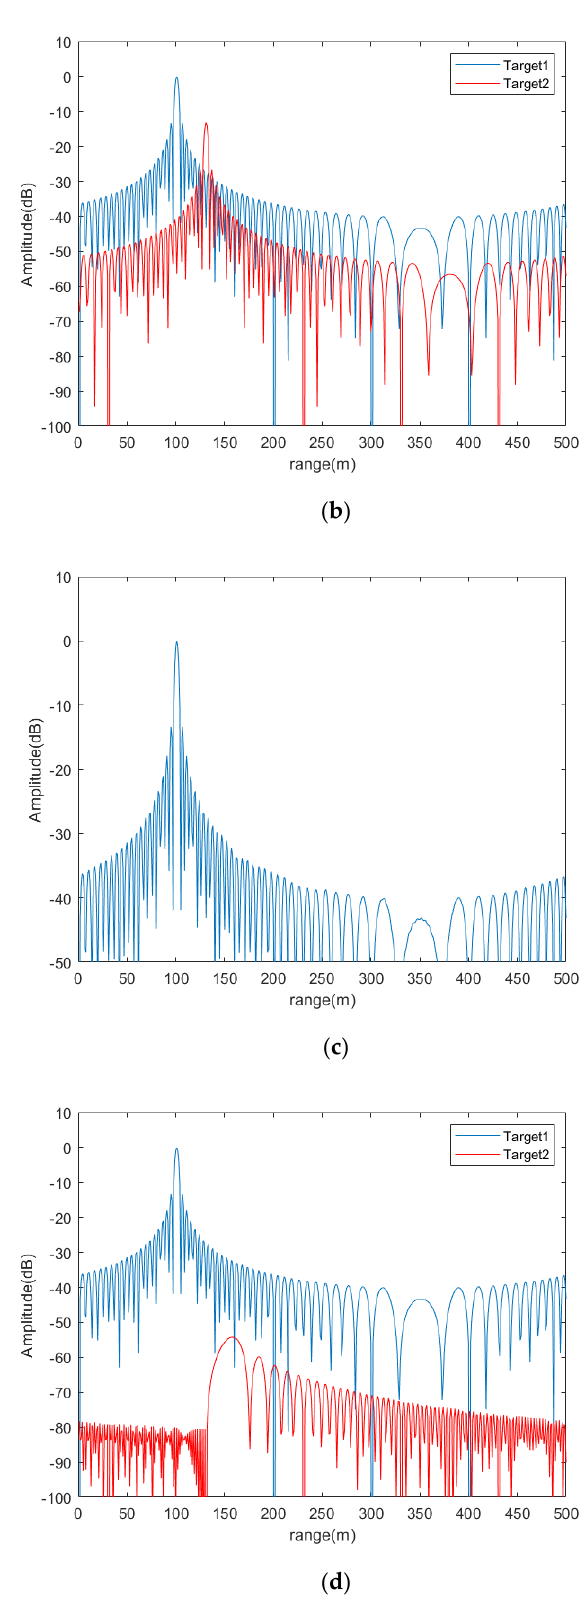
Figure 11. Ability of suppressing the range ambiguity. ( a ) demodulation results of mixed echo with digital beam forming (DBF) in receiving. ( b ) demodulation results of each target with DBF in receiving. ( c ) demodulation result of mixed echo with proposed method. ( d ) demodulation results of each target with proposed